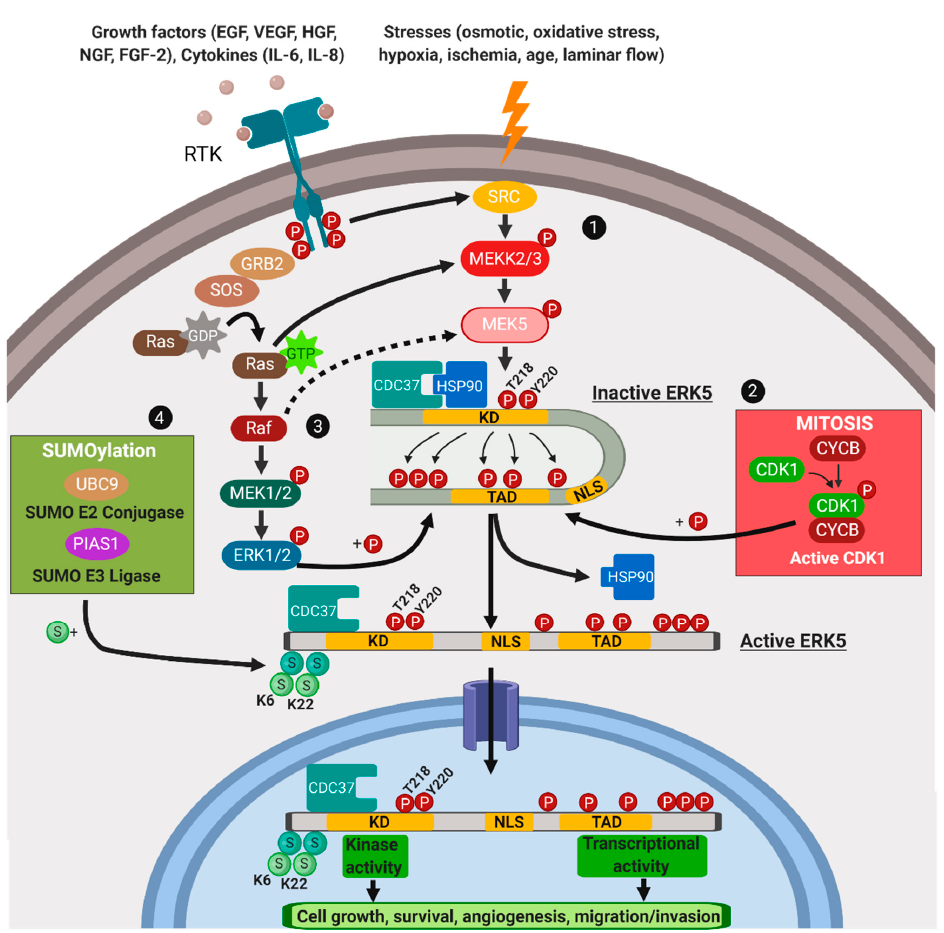
Figure 1. ERK5 nuclear translocation. In the inactive state, the N-terminal half of ERK5 interacts intra-molecularly with the C-terminal half, and the chaperones HSP90 and CDC37 are bound to ERK5. In this conformation ERK5 resides in the cytosol. (1) Upon MEK5-mediated phosphorylation of the TEY motif and subsequent activation, ERK5 auto-phosphorylates its C-terminal half determining the intramolecular interaction, and inducing a conformational change that results in the dissociation from HSP90, exposition of the NLS, and nuclear translocation. Alternatively, MEK5-independent mechanisms resulting in ERK5 phosphorylation and nuclear translocation include: (2) phosphorylation by CDK1 at S753 and/or T732 in mitosis; (3) MEK1/2-ERK1/2-dependent mechanism, involving ERK5 phosphorylation at T732, under growth factors stimulation and/or oncogene activation. (4) Regulation of ERK5 nuclear shuttling by SUMOylation at the N-terminus. Solid lines indicate direct established regulatory interactions, whereas broken lines illustrate putative interactions (created with Biorender.com). ERK5 is expressed in a number of cell types, and its intracellular localization under routine culture conditions varies largely [21], ranging from a predominantly nuclear pattern, such as that in